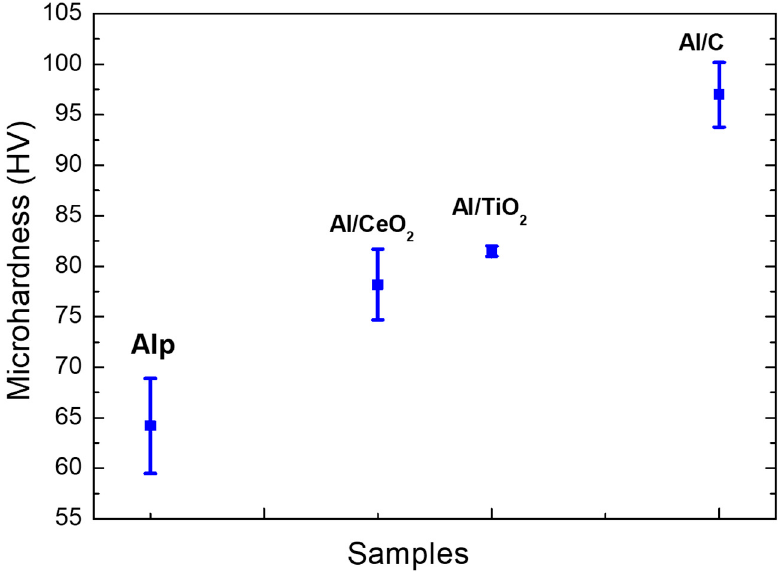
Figure 17. Microhardness values as a function of composite types.